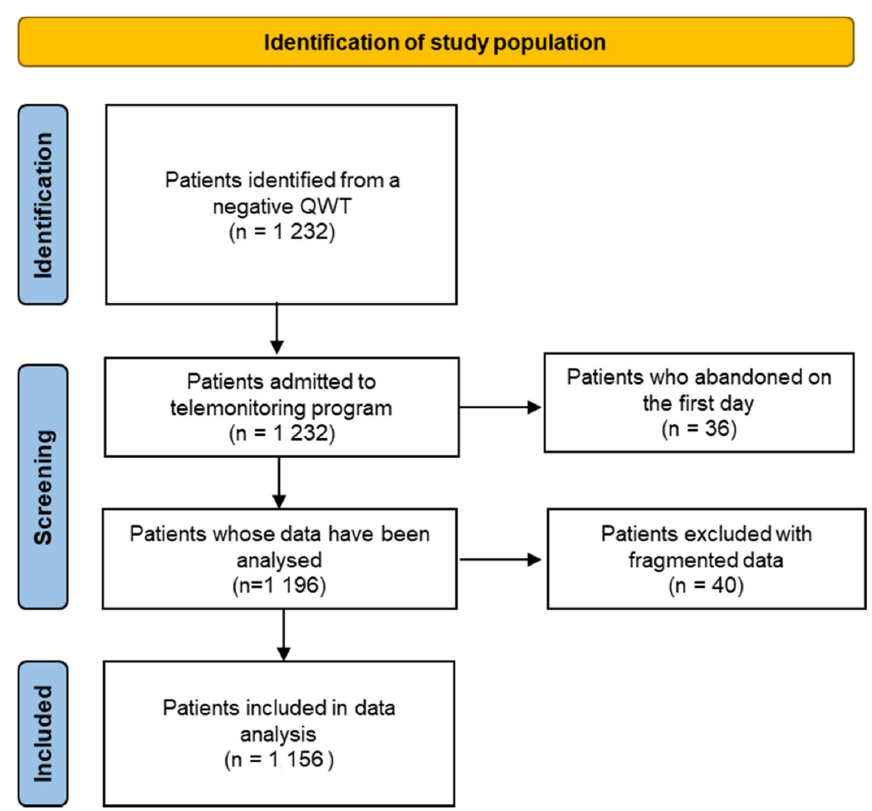
Figure 1. Identification of study population.